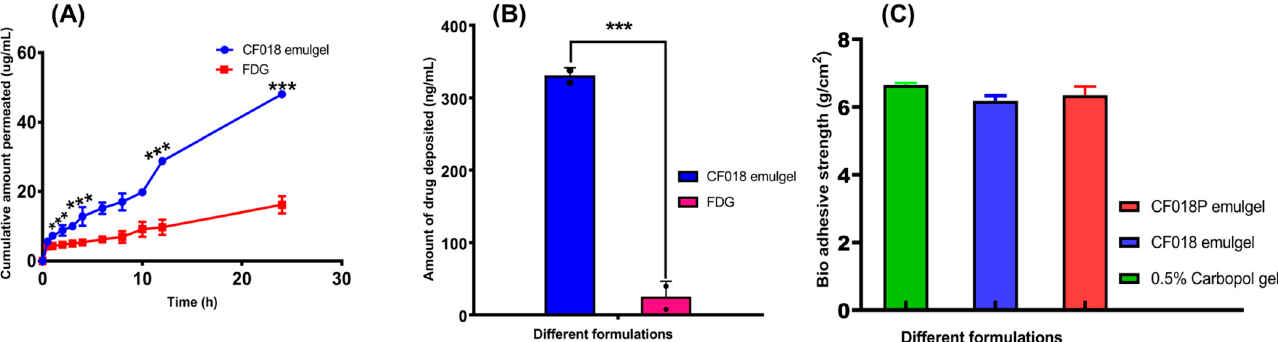
Figure 10. Ex vivo characterization of CF018 emulgel and DTB loaded gel. ( A ) Ex vivo permeation study of CF018 emulgel and FDG. ( B ) Skin deposition study. ( C ) Comparative bio-adhesion strength. *** p < 0.001 vs. FDG .